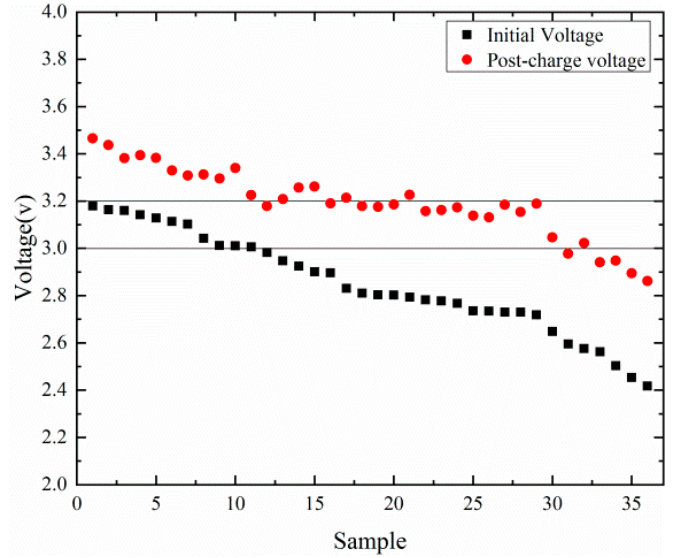
Figure 2. Post-charge voltage of 36 retired batteries.